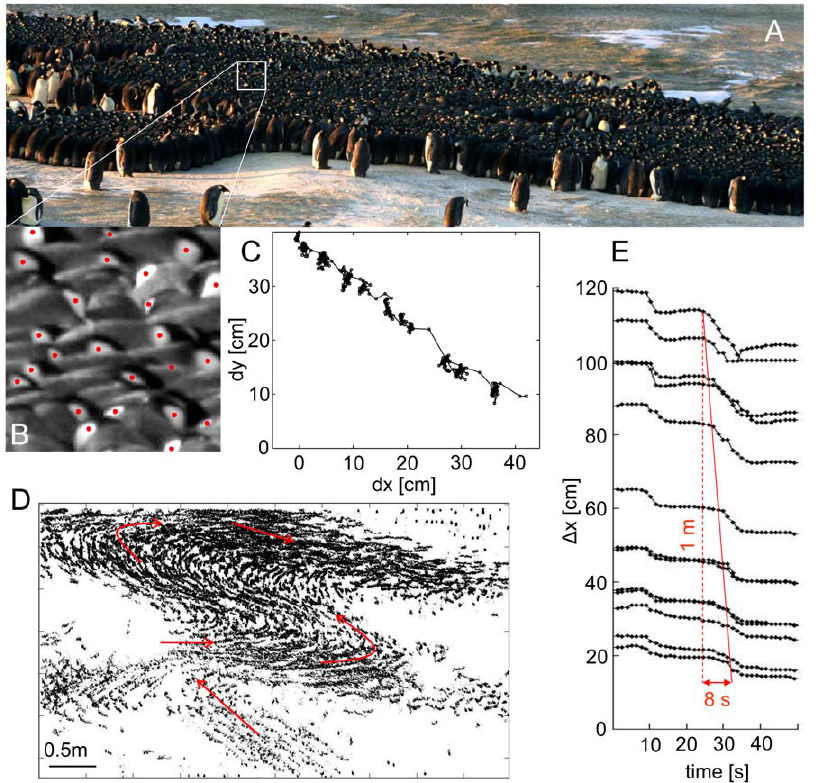
Figure 1. Coordinated movements in an emperor penguin huddle. (A) Observed field of view of the emperor penguin colony. The image shows several huddles and individual penguins. The density of penguins in huddles is approximately 21 animals per square meter. (B) The penguins’ yellow and white face patch was used to track individual animals. (C) Typical trajectory of a penguin during huddle movements. Motionless periods are interrupted by intermittent small steps that lead over time to a reorganization of the entire huddle. (D) Positions of penguins tracked over 4 hours show a collective huddle movement as indicated by red arrows (movies available online). (E) Trajectories from neighboring penguins with similar vertical (y) positions show correlated steps in the horizontal (x) direction. The speed of the propagating wave is indicated by the slope of the red line.